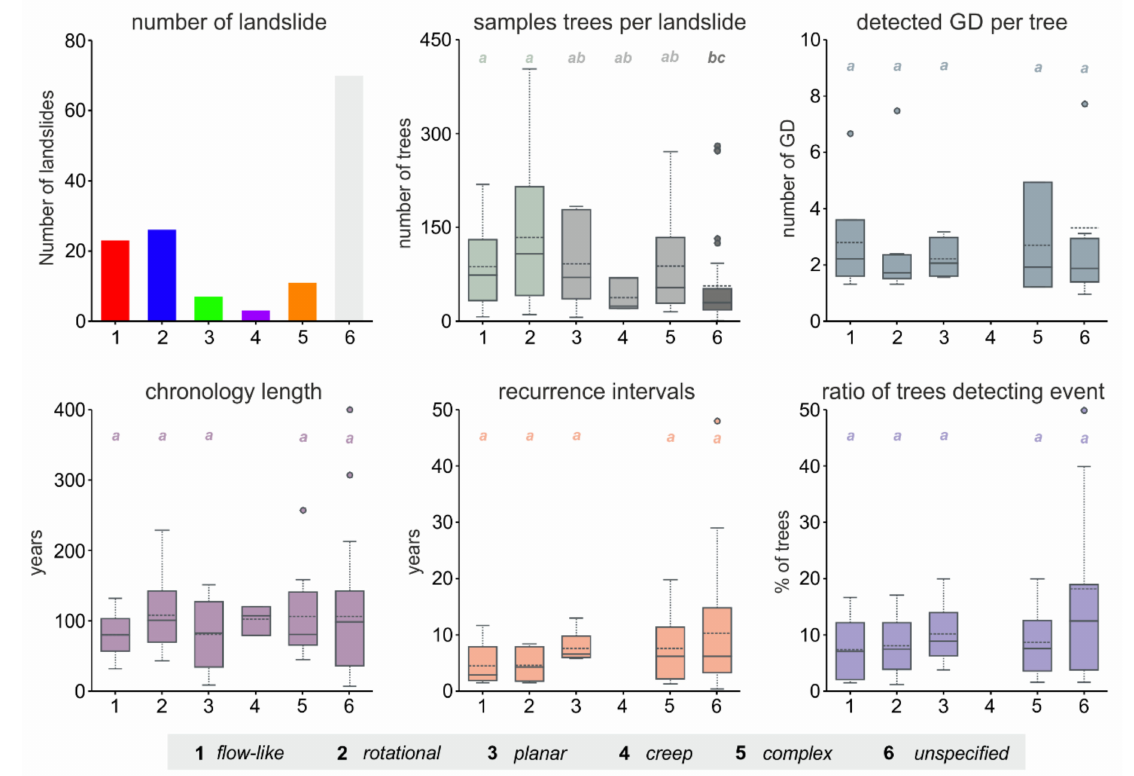
Figure 6. Comparison of basic dendrogeomorphic aspects in landslides of various